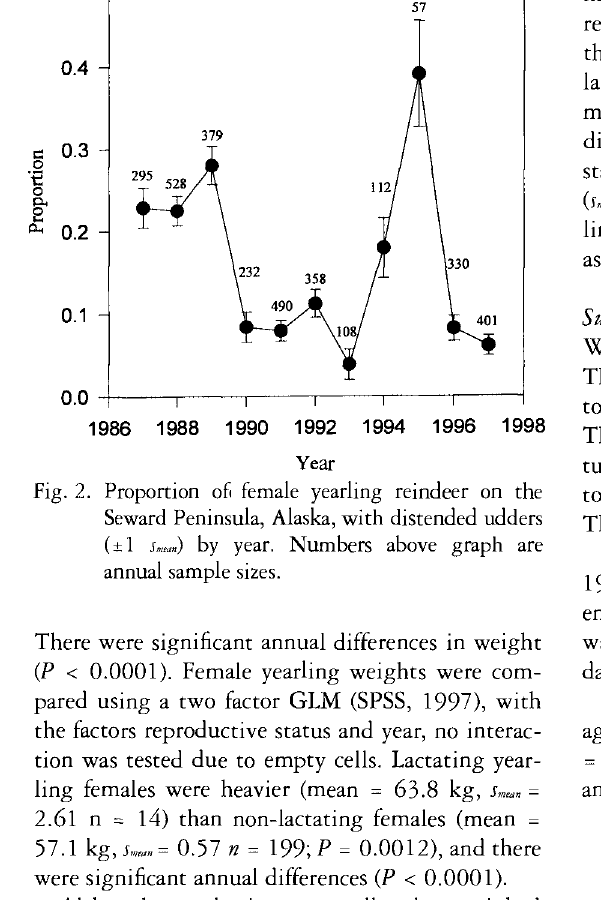
Fig. 2. Proportion of female yearling reindeer on the Seward Peninsula, Alaska, with distended udders (±1 Sm*n) by year. Numbers above graph are annual sample sizes.